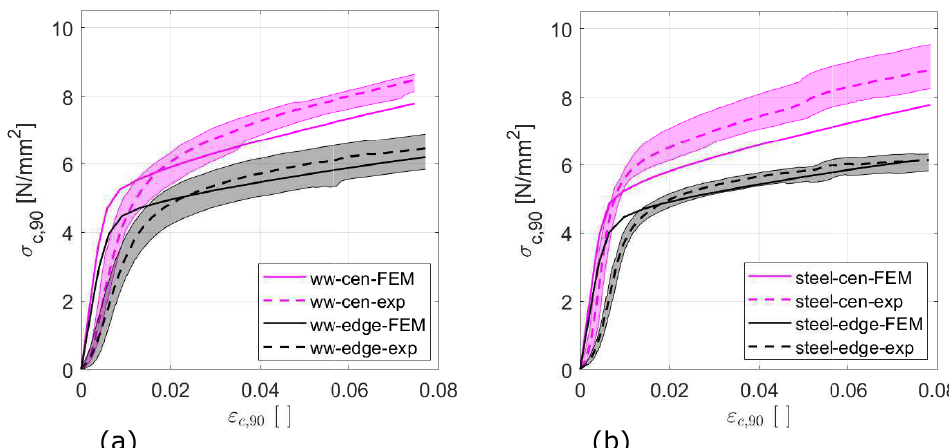
Figure 7. Compression stress vs. strain curves for loading and supporting with ( a ) CLT walls and ( b ) steel plates in series W80-F140 .